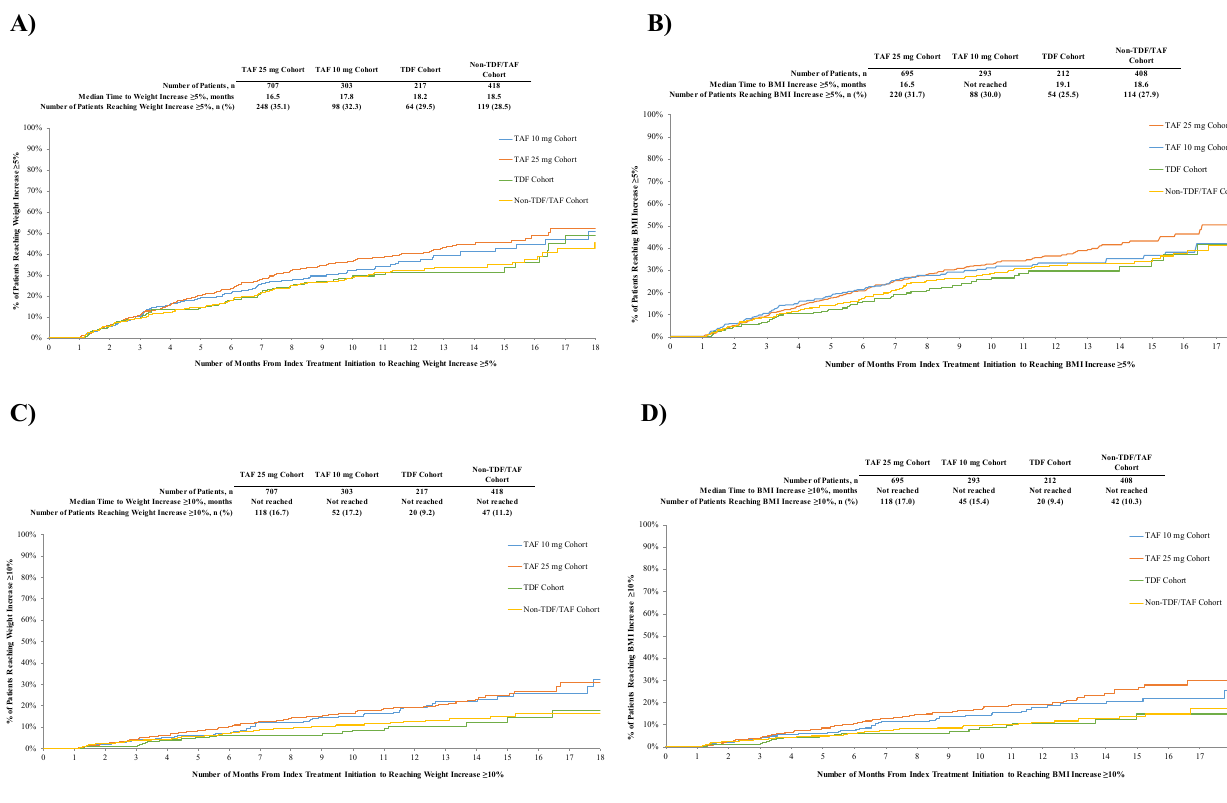
Abbreviations: BMI, body mass index; TAF, tenofovir alafenamide; TDF, tenofovir disoproxil